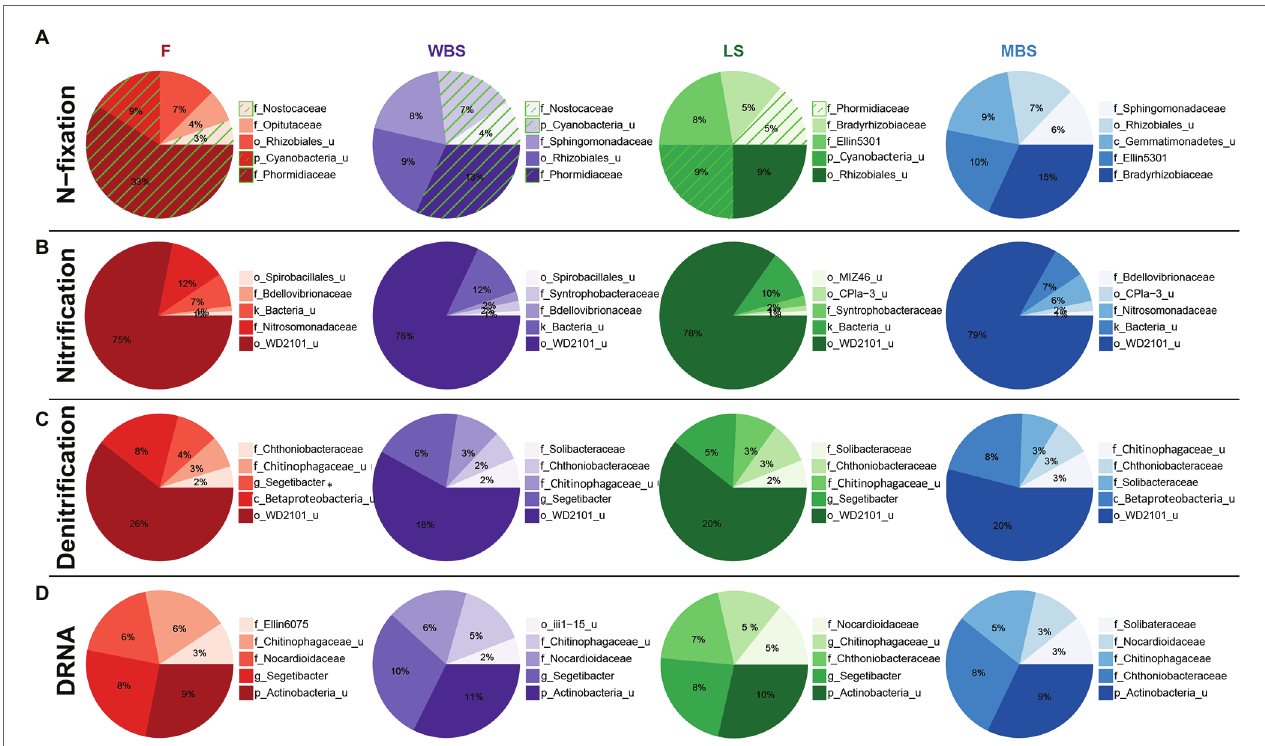
FIGURE 8 | Top five family-level functional designees across elevation levels for (A) N-fixation (cyanobacterial taxa highlighted by green hatching), (B) nitrification, (C) denitrification, and (D) dissimilatory nitrate reduction to ammonia (DNRA). Area of each pie slice is proportional to the family’s percentage among the top five families. Numbers in the text are percentages of the families with respect to all taxa in the communities. “_u” = “unclassified”; “g_Segetibacter” = “f_